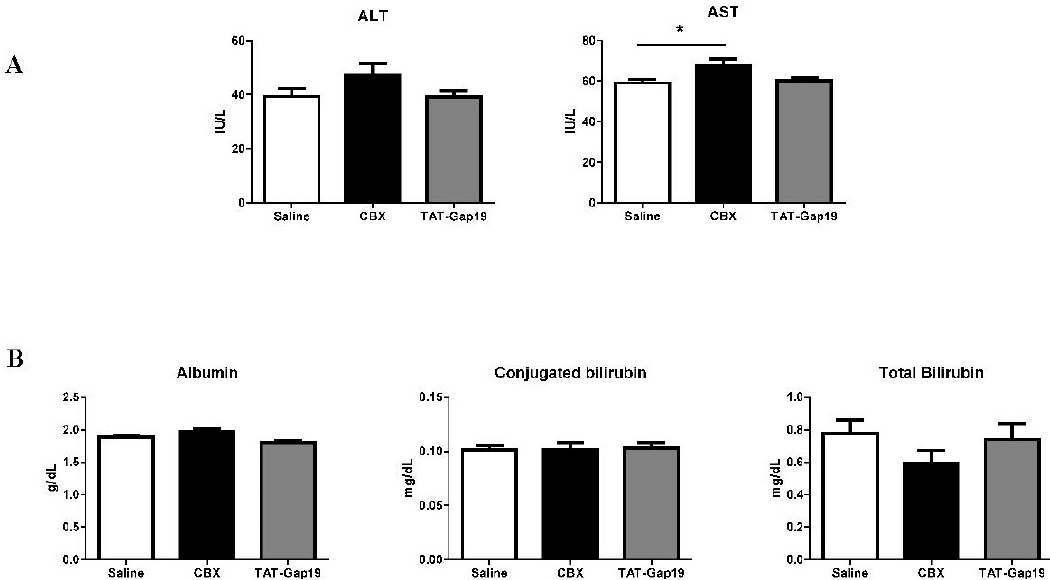
Figure 3. Effects of CBX and TAT-Gap19 on biochemical parameters after TAA-induced chronic hepatic injury in mice. Mice were administered TAA intraperitoneally for 8 weeks. Initially, mice ( n = 15/group) were administered with 100 mg TAA/kg body weight, followed by 10% weekly increments to the utmost dose of approximately 200 mg TAA/kg body weight. Thereafter, an osmotic pump was implanted in the peritoneal cavity, which ensured the release of 1 mg TAT-Gap19 or CBX/kg body weight/ or saline for two weeks. ( A ) Serum levels of the necrotic cell death markers namely ALT and AST, ( B ) Serum levels of the hepatic functionality markers albumin, conjugated and total bilirubin. Results were analyzed by 1-way ANOVA followed by post hoc tests Bonferroni correction. Data were expressed as means ± SEM (* p ≤ 0.05).